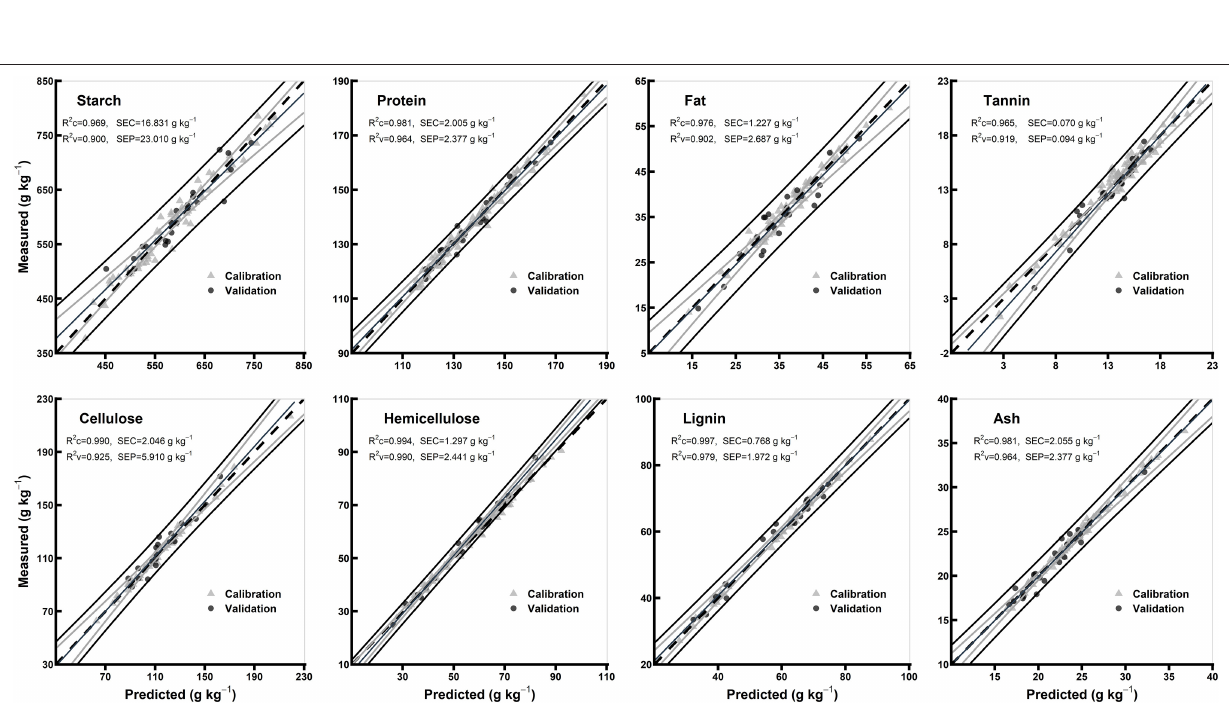
FIGURE 5 | Comparison of scatter plots of measured vs. predicted values (g kg − 1 ) of the whole grain flours for starch, protein, fat, tannin, cellulose, hemicellulose, lignin, and ash of sorghum grains for the external validation subsets based on PLSR models. The black and gray lines in plot showed mean, maximum, and minimum values while dotted lines showed average chemical composition between calibration and validation sample